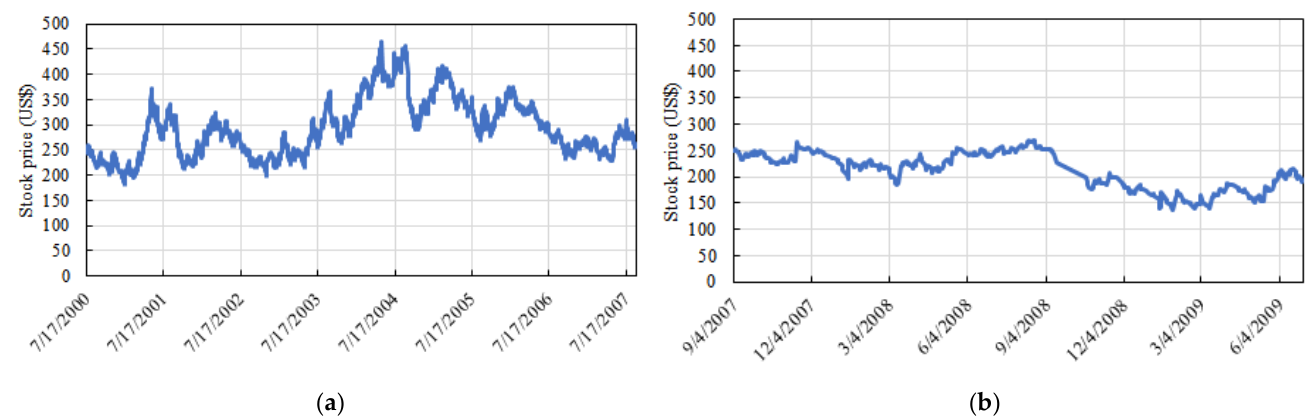
Figure 1. Evolution of training set ( a ) and testing set ( b ) over time for the Random Length stock price for the great recession modeling.